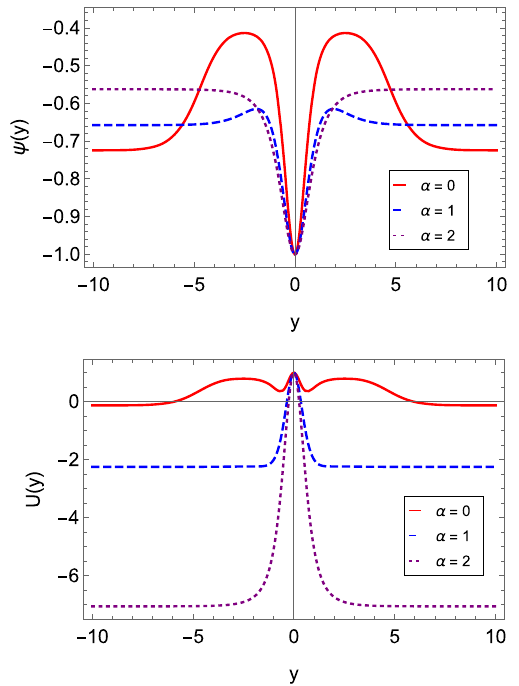
Fig. 8 Numerical solutions for ϕ( y ) (top panel) and U ( y ) (bottom panel) from Eqs. (50) to (52) with ψ 0 = − 1, φ 0 = U 0 = k = 1 for different values of α